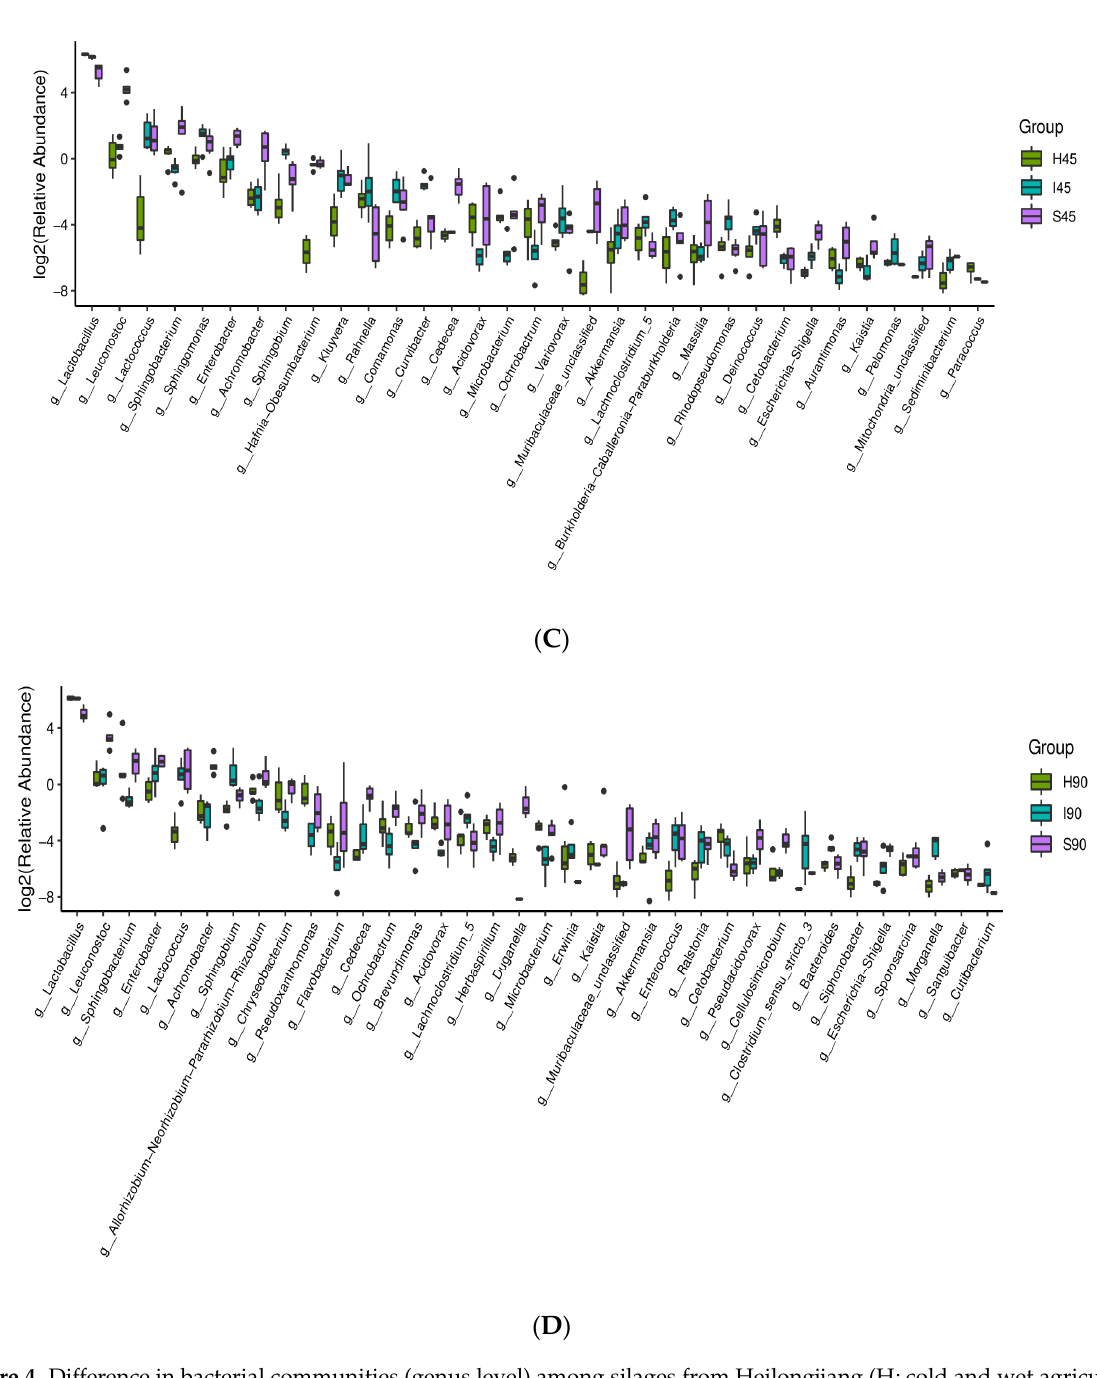
Figure 4. Difference in bacterial communities (genus level) among silages from Heilongjiang (H; cold and wet agricultural area), Inner Mongolia (I; temperate and dry pastoral area), and Shanxi (S; temperate and dry agricultural area) at ( A ) 5 and ( B ) 14 days after ensiling ( n = 6), and ( C ) 45 and ( D ) 90 days after ensiling ( n = 6).